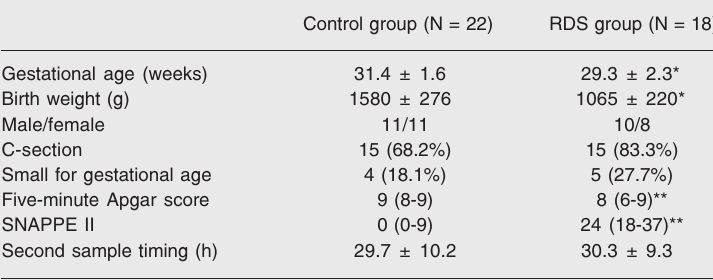
Table 1. Characteristics of the population studied.